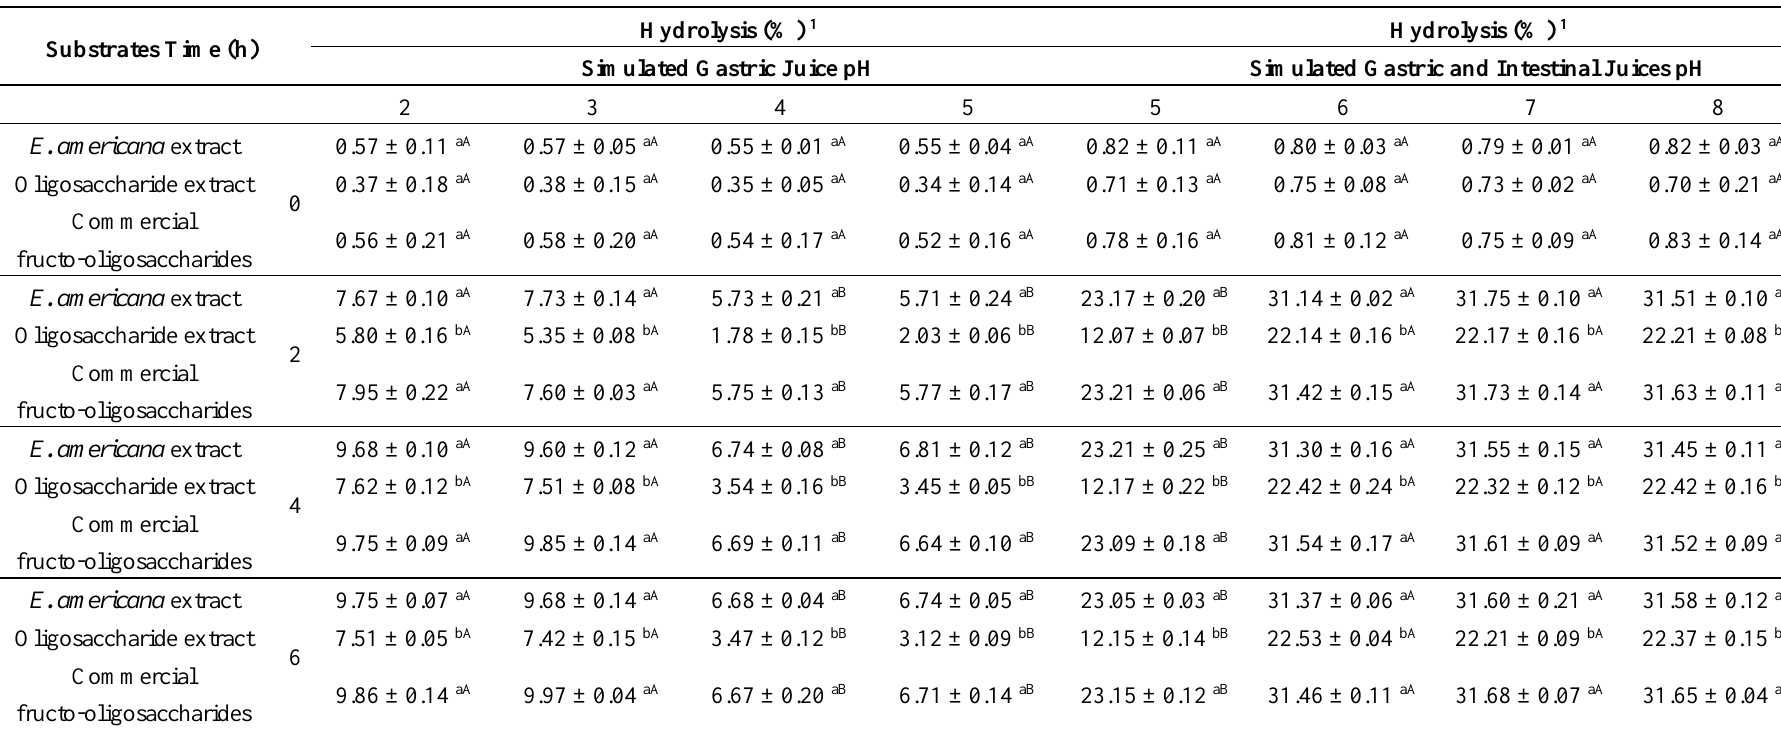
Values are the means ± the standard deviation from duplicate determinations; different superscript uppercase letters (A, B) in the same row are significantly different ( p < 0.05); different superscript lowercase letters (a, b) in the same column are significantly different among different substrates for each time ( p < 0.05); 1 Hydrolysis (%) = reducing sugar released/total sugar content-initial reducing sugar content ×